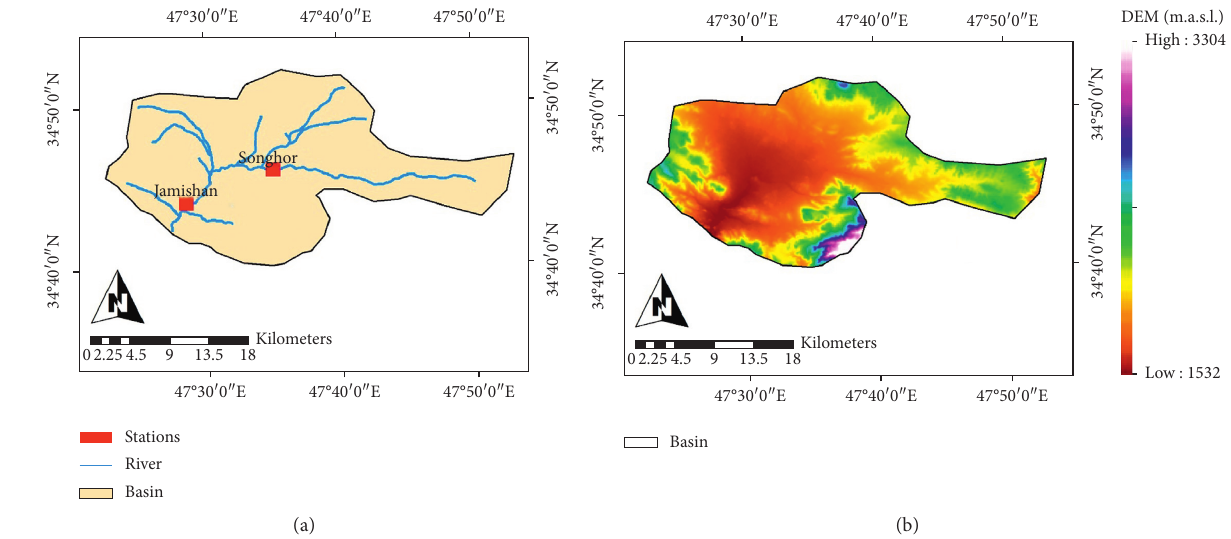
Figure 1: (a) The Jamishan River basin, and (b) the digital elevation model of the